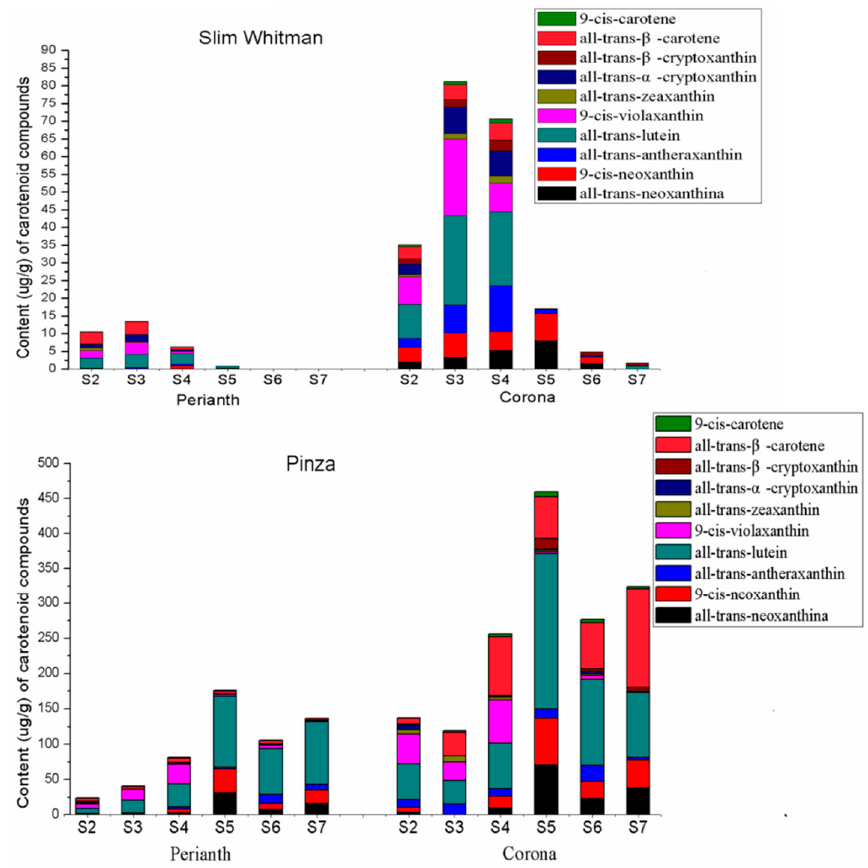
Figure 2. The content ( µ g/g) of carotenoid compounds in perianths and coronas of SW and PZ in